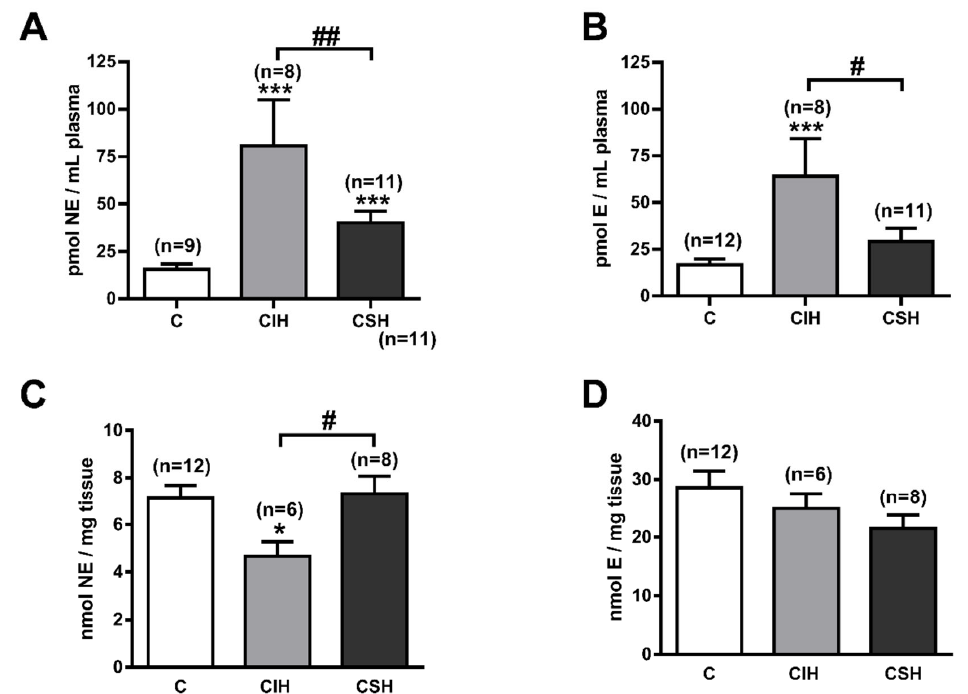
Figure 3. Plasma and adrenal medulla catecholamine content. ( A ) Endogenous content of plasma norepinephrine (NE; pmol/mL) from C, CIH, and CSH rats. Data are expressed as mean ± SEM; *** p < 0.001 vs. C. One-way ANOVA with Tukey’s multiple comparisons test: ## p < 0.01 CIH vs. CSH, One-way ANOVA with Sidak’s multiple comparisons test. ( B ) Endogenous content of plasma epinephrine (E; pmol/mL) from C, CIH, and CSH rats. Data are expressed as mean ± SEM; *** p < 0.001 vs. C. One-way ANOVA with Tukey’s multiple comparisons test: # p < 0.05 CIH vs. CSH One-way ANOVA. ( C ) Endogenous content of adrenal medulla norepinephrine (NE; nmol/mg tissue) from C, CIH, and CSH rats. Data are expressed as mean ± SEM; * p < 0.05 vs. C. One-way ANOVA with Tukey’s multiple comparisons test: # p < 0.05 CIH vs. CSH One-way ANOVA. ( D ) Endogenous content of adrenal medulla epinephrine (E; nmol/mg tissue) from C, CIH, and CSH rats. Data